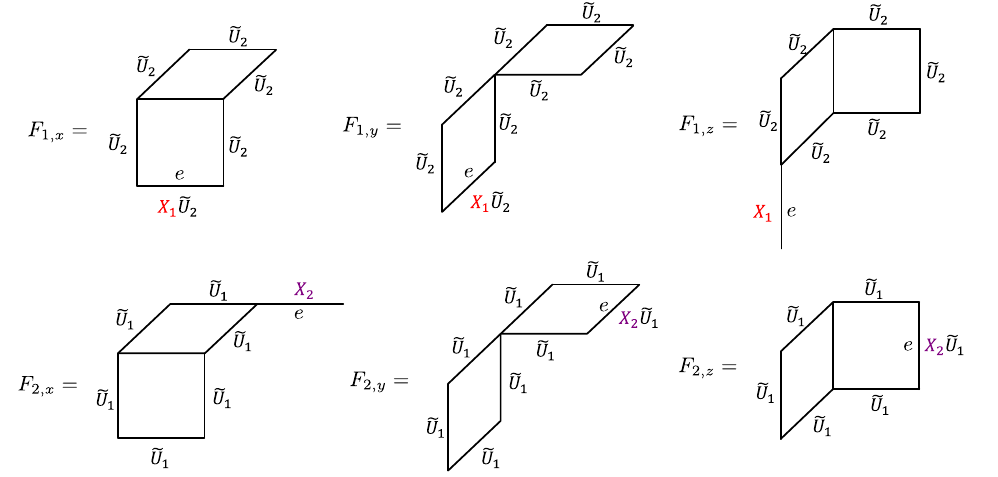
FIG. 8. The mutually commuting flippers associated with the separators in Fig. 7. Again, we note that each flipper is equivalent to a single-site Pauli operator multiplied by a closed string of hopping